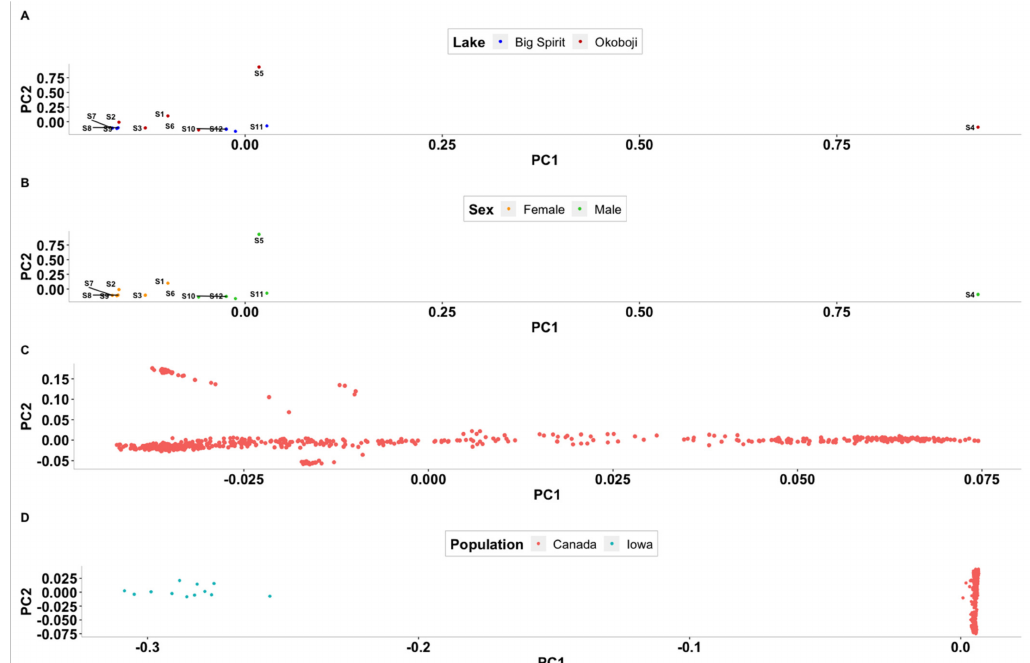
Figure 4. Principal component analysis (PCA) results. ( A ) Samples from Iowa colored by lake of origin. Big Spirit in blue and Okoboji in red. Principal components 1 and 2 account for 11.74% and 11.72% of the variance, respectively. ( B ) Samples from Iowa colored by sex. Females in orange and males in green. Principal components 1 and 2 account for 11.74% and 11.72% of the variance, respectively. ( C ) Samples from Canada. Principal components 1 and 2 account for 27.24 % and 20.58% of the variance, respectively. ( D ). Principal component analysis (PCA) results for Iowa and Canada populations combined. Principal components 1 and 2 account for 65.24% and 9.39% of the variance, respectively. PC1 and PC2 indicate principal component 1 and 2, respectively. Canada samples in red and Iowa samples in